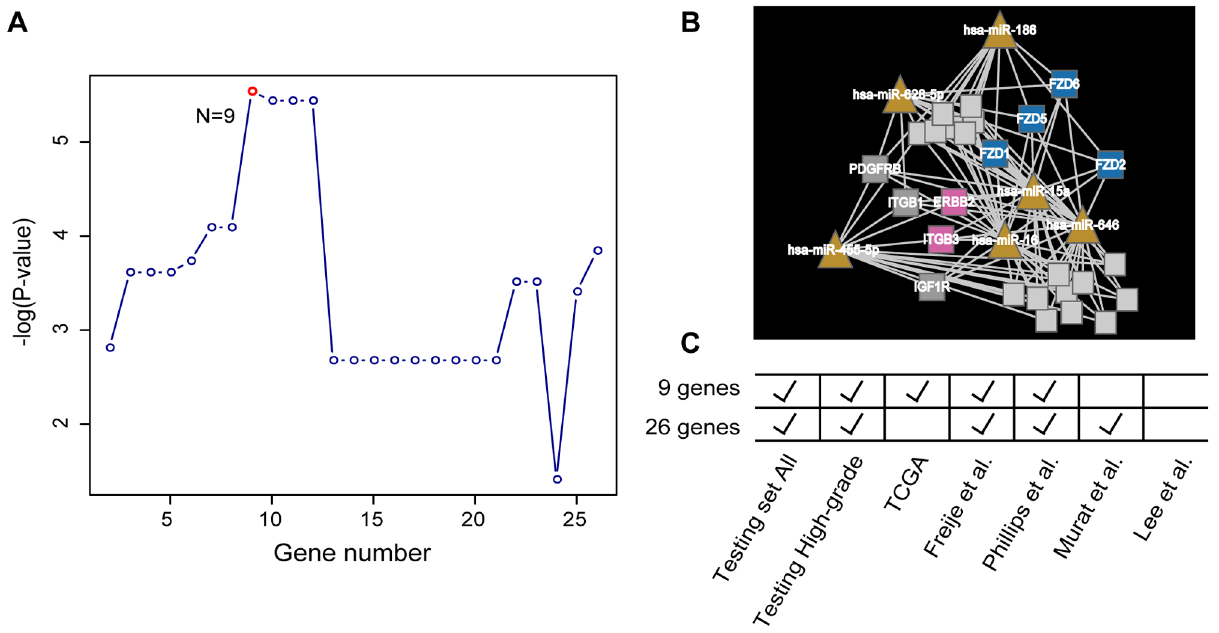
Figure 5. The survival prediction performance of the 9-gene signature from moduleS3. ( A ). The identification of top 9 genes from the moduleS3. ( B ). The 9 genes in moduleS3. Gene nodes were colored according to the gene class colors used in Figure?2. ( C ). The survival prediction power comparison between 9-gene and 26-gene signatures.